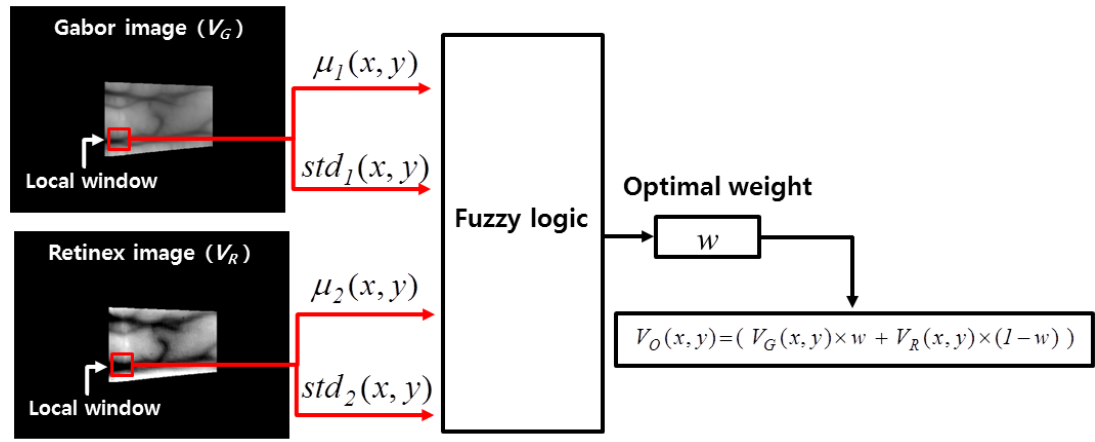
Figure 11. Illustration of the proposed fuzzy-based image fusion